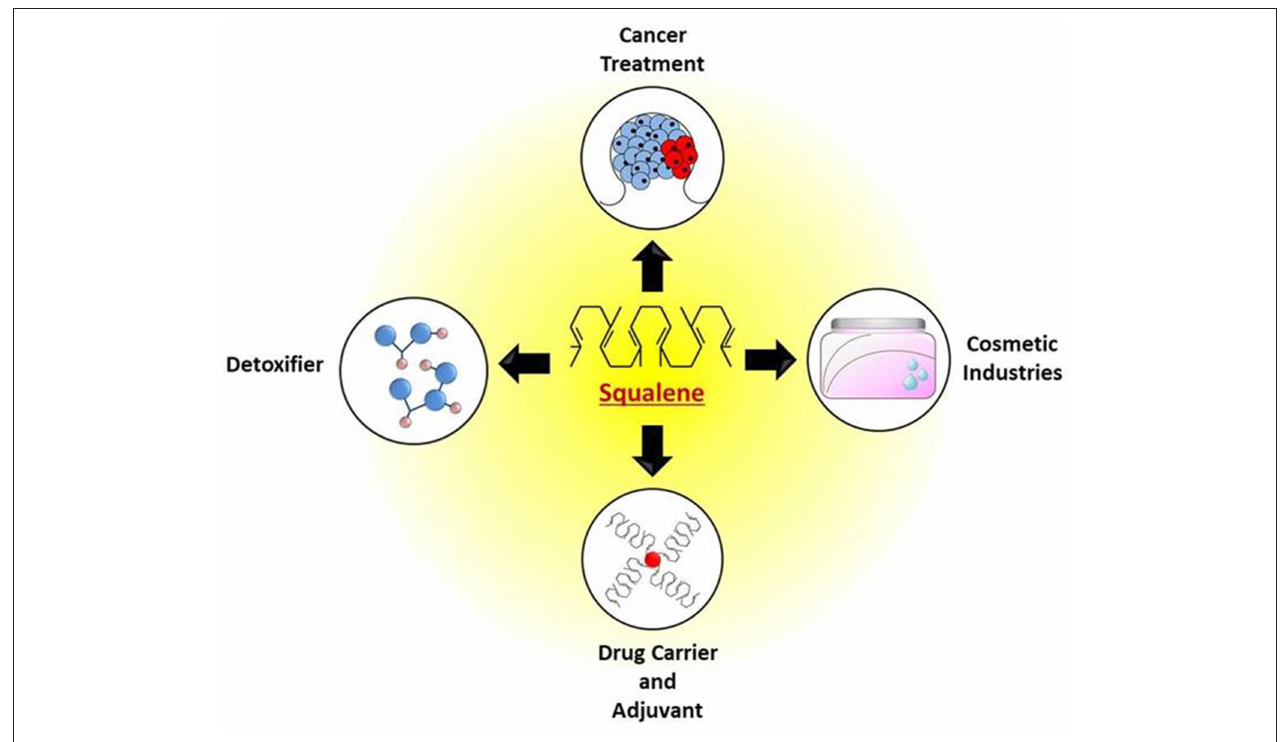
FIGURE 4 | Potential applications of squalene for treatment of cancer, as detoxifier, use in cosmetics, drug and vaccine